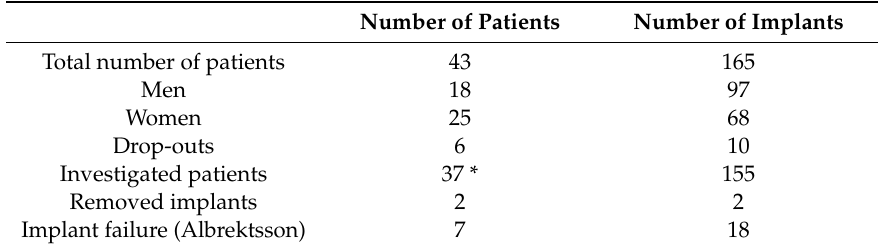
Figure 1. Number of inserted implants per patient ( n = 155). Table 1. Overview of patients regarding number, sex, drop-outs, and implant removal.